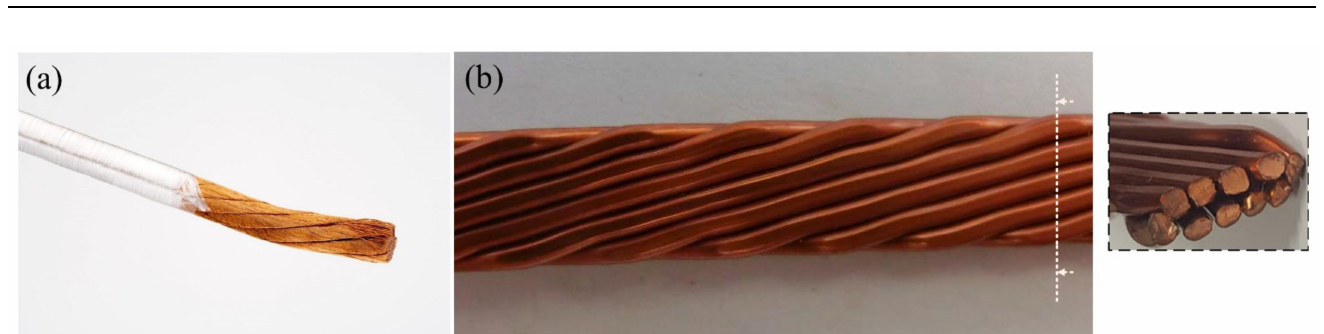
Figure 10. Common types of litz wire ( a ) type 2: round profile [45]; ( b ) type 8: rectangle compacted profile